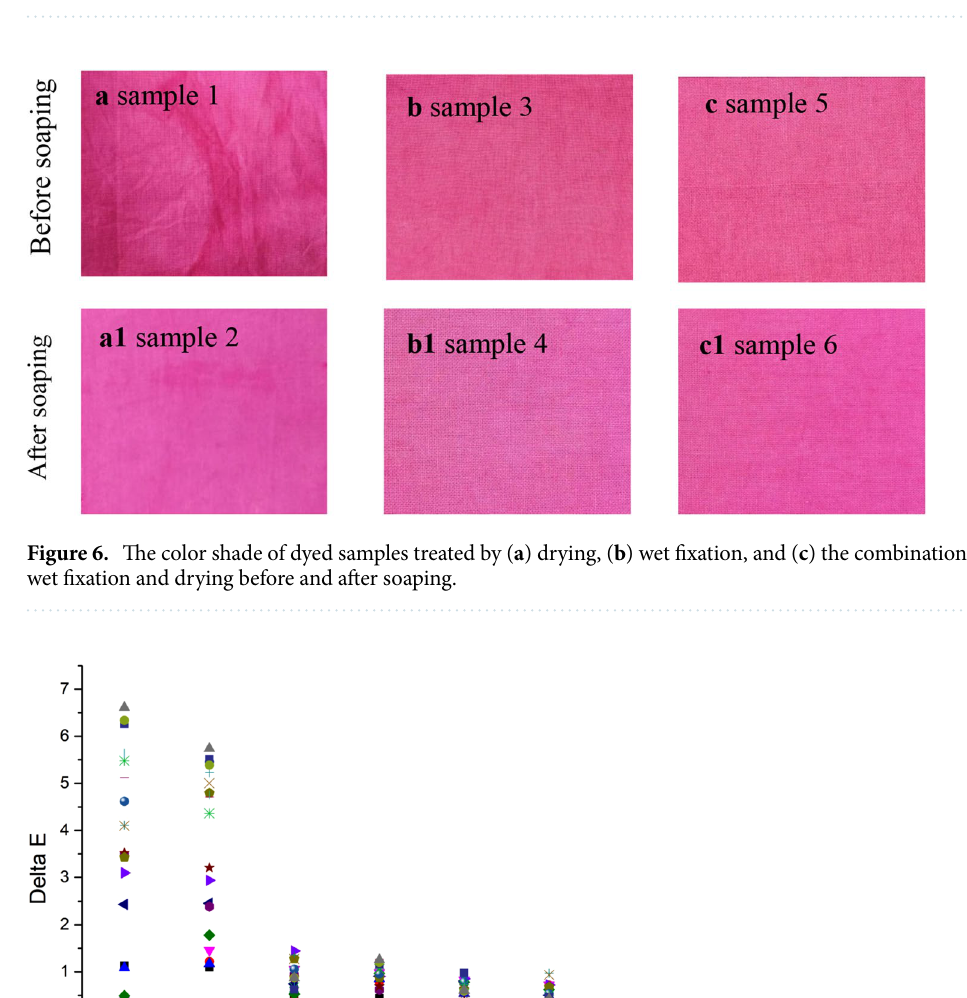
Figure 5. Color uniformity (standard deviation of K/S) of samples treated by fixation treatments.